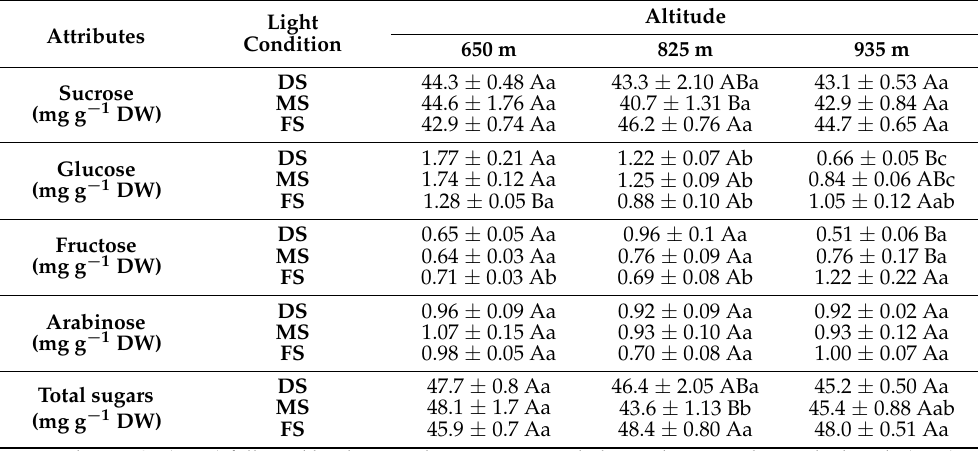
Table 6. Evaluation of soluble sugars in green coffee beans from C. arabica obtained under three light exposure conditions (deep shade, DS; moderate shade, MS; full Sun, FS), and three altitude (650 m, 825 m and 935 m) in Gorongosa